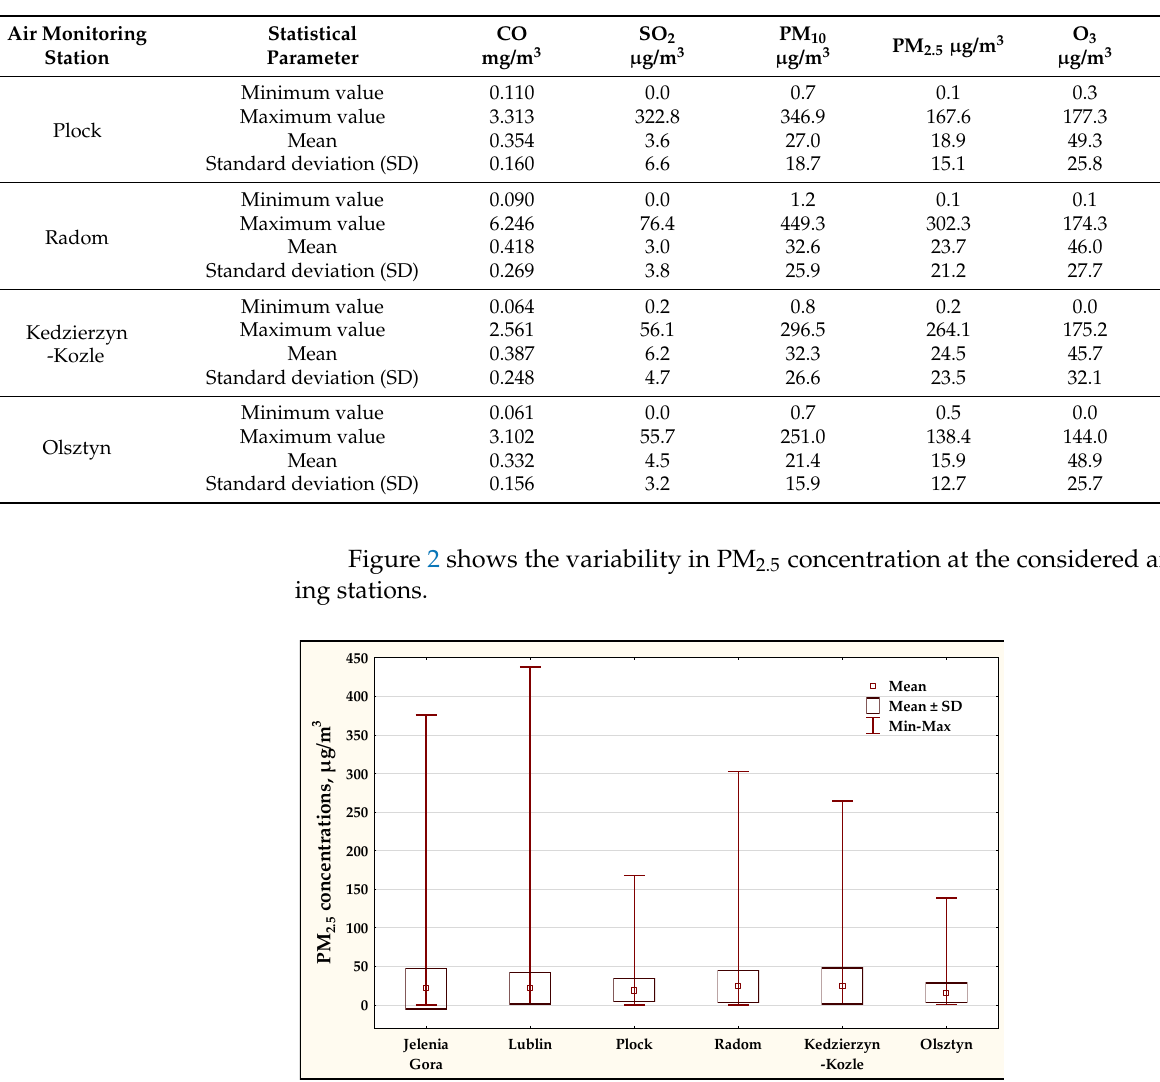
Figure 2. Distribution of PM 2.5 concentrations at various air monitoring stations in 2015 – 2021.